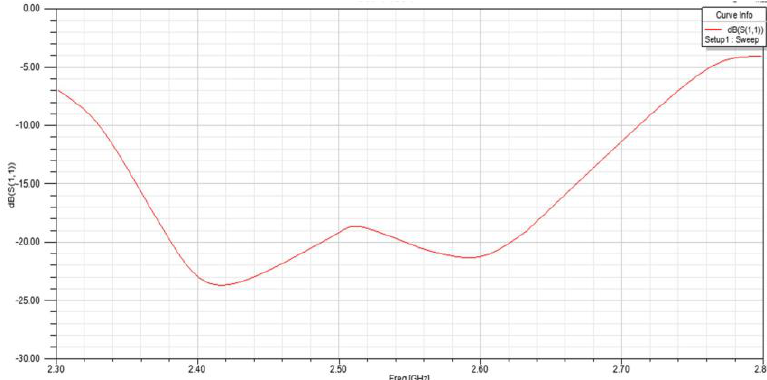
Fig. 6. The model of integrated antenna Such antenna simulation procedure coincide with the calculation of conventional microstrip antenna. Fig. 7 - 9 show the results of the integrated antenna modelling.